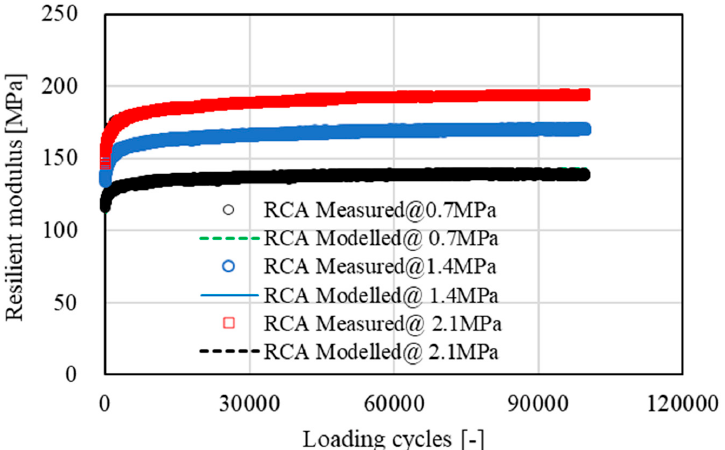
Figure 9. Development of resilient modulus of recycled concrete aggregate (RCA) under cyclic loading.